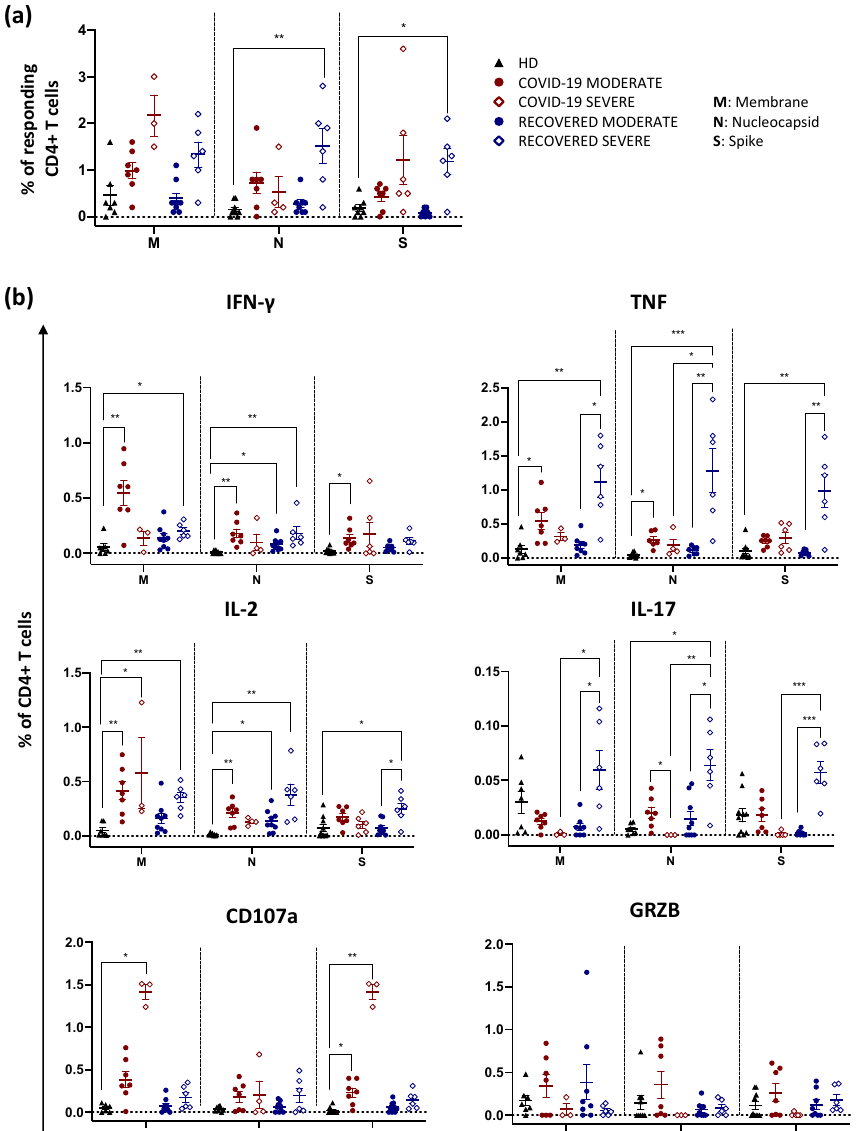
Figure 1. Total cytokine production by CD4+ T cells after in vitro stimulation. ( a ) Percentage of responding CD4+ T cells after stimulation with M, N or S. Data represent individual values from healthy donors (HD, n = 10), COVID-19 moderate ( n = 7), COVID-19 severe ( n = 6), recovered moderate ( n = 9) and recovered severe ( n = 6). Mean (center bar) ± standard error of the mean (SEM, upper and lower bars) is represented. Statistical analysis was performed using Kruskal–Wallis non-parametric test corrected for multiple comparisons by controlling the False Discovery Rate (FDR), method of Benjamini and Hochberg. * q < 0.05; ** q < 0.01. Background was subtracted from each sample. ( b ) Representation of the total production of each cytokine after stimulation of CD4+ T cells. We evaluated the percentage of CD4+ T cells producing IFN- γ , TNF, IL-2, IL-17, GRZB as well as expressing CD107a among HD ( n = 10), COVID-19 moderate ( n = 7), COVID-19 severe ( n = 6), recovered moderate ( n = 9) and recovered severe ( n = 6). Data are represented as individual values, mean (center bar) ± standard error of the mean (SEM, upper and lower bars) is represented. Statistical analysis was performed using Kruskal–Wallis non-parametric test corrected for multiple comparisons by controlling the False Discovery Rate (FDR), method of Benjamini and Hochberg. * q < 0.05; ** q < 0.01; *** q < 0.001. Background (i.e., the value determined in unstimulated controls) was subtracted from each